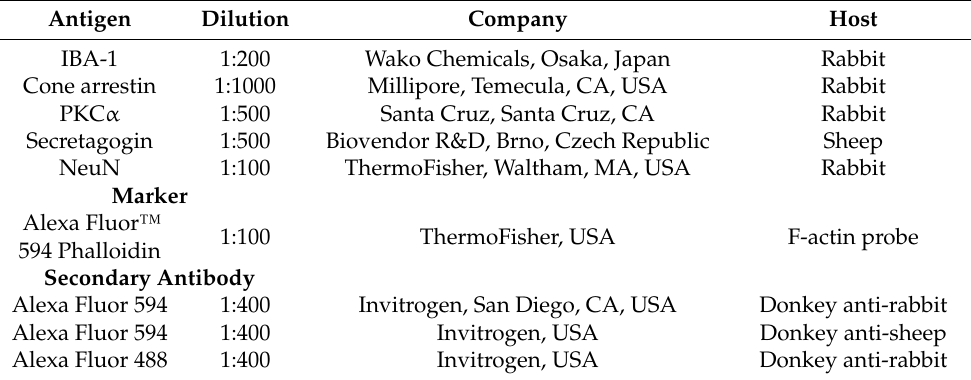
Table 2. Primary and secondary antibodies used in immunofluorescence